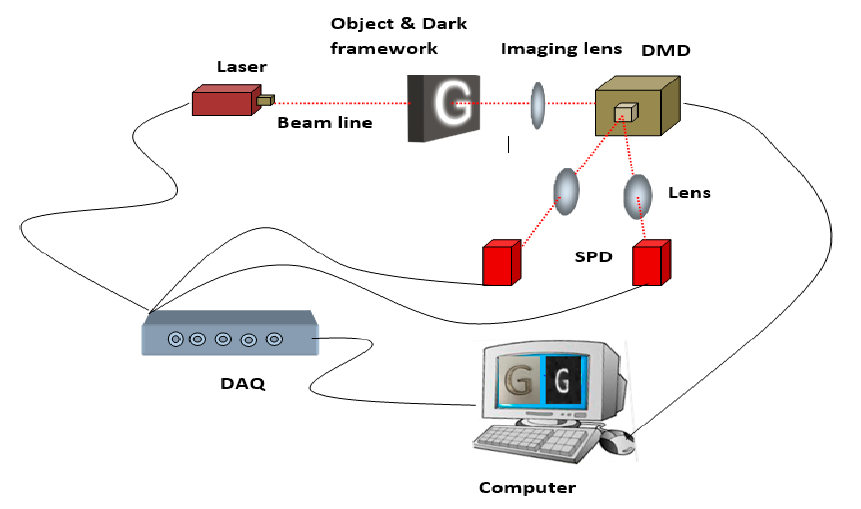
Figure 1. Schematic of 3D transparent object detection and disparity map acquisition system. The red dashed line indicates the laser light beam from the source to detectors.